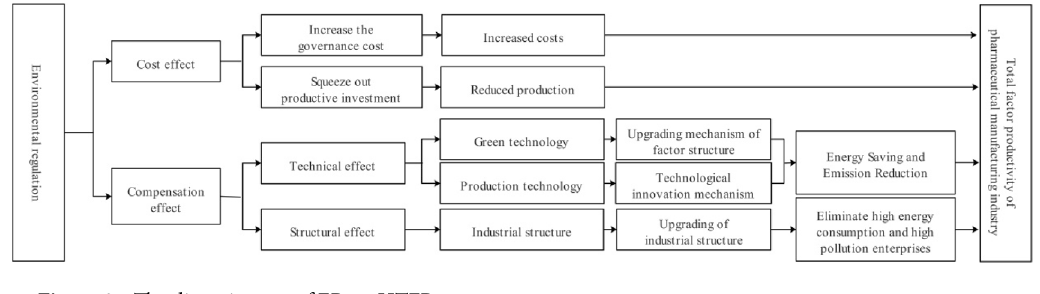
Figure 2. The direct impact of ER on